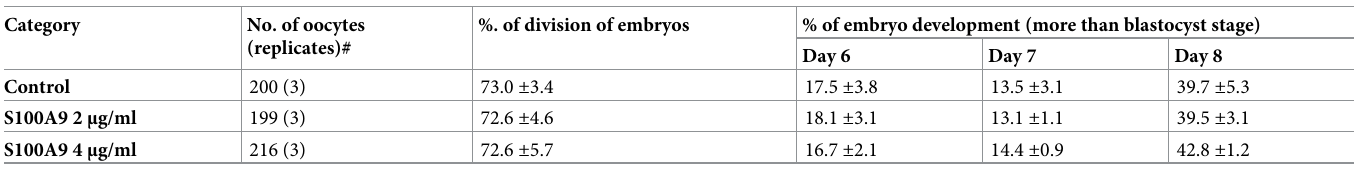
Table 1. Effect of S100A9 on bovine sperm fertilization capacity in the IVF procedure. Category